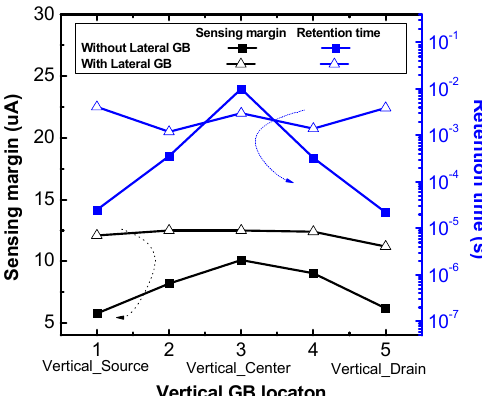
Figure 7. The sensing margin and retention time of poly ‐ Si 1T ‐ DRAM devices without and with a lateral GB according to a vertical GB location. Numbers from 1 to 5 on the x ‐ axis are in order starting from the source region. The location numbers 1, 3 and 5 indicate Vertical_Source, Vertical_Center and Vertical_Drain, respectively.